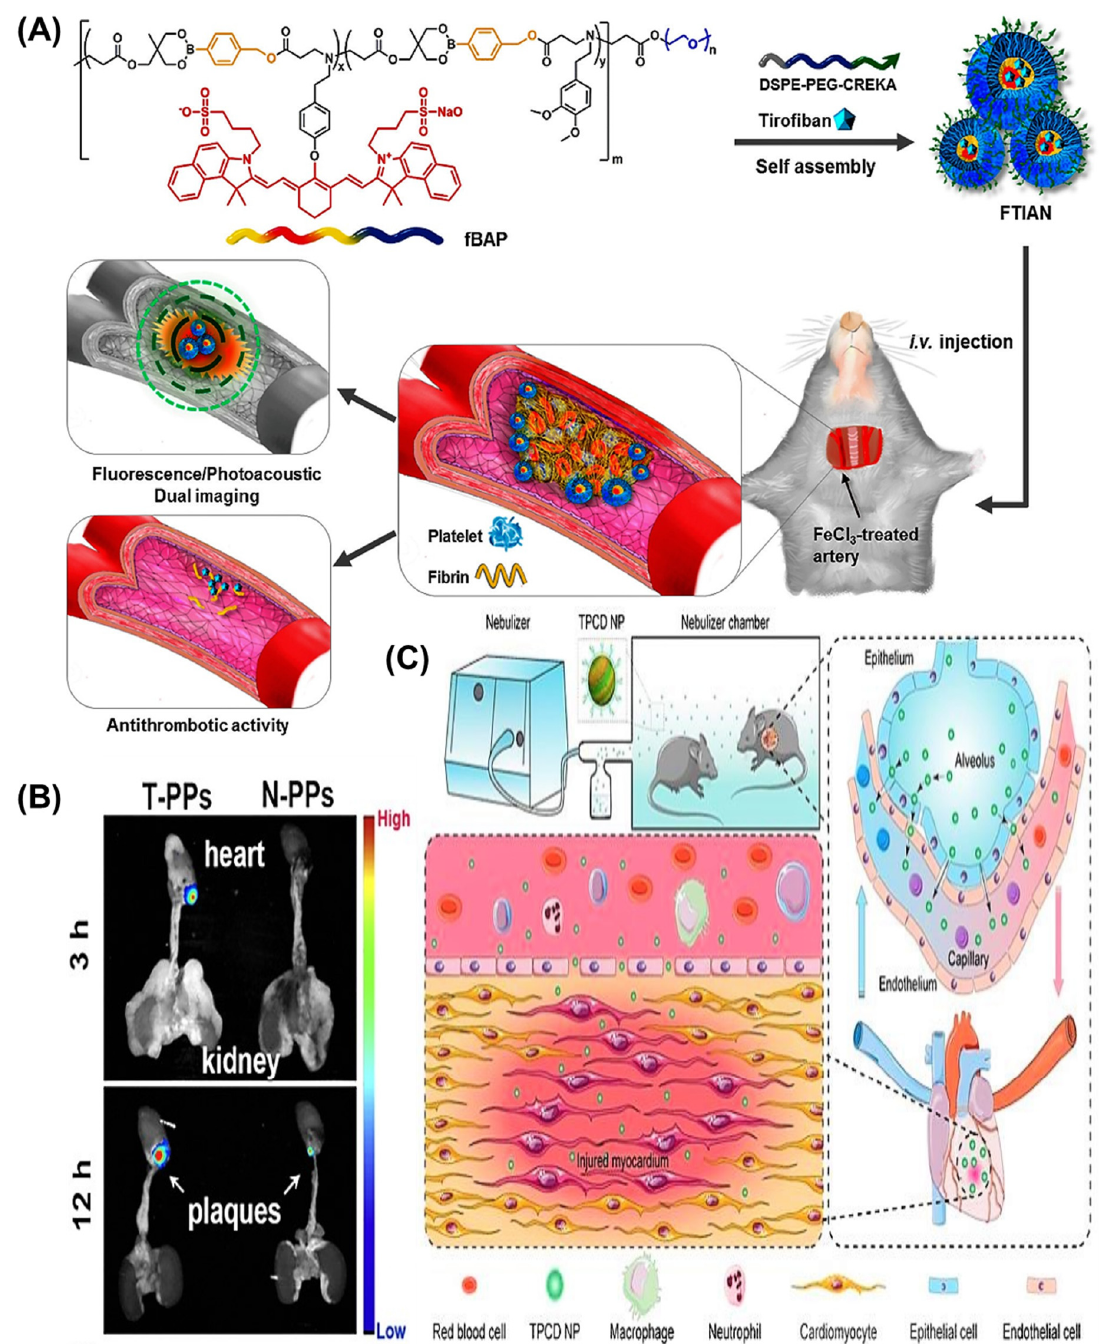
Figure 2. Theranostic nanomedicine for diagnosis and therapy of cardiovascular and related diseases. ( A ) A schematic representation of FTIAN as a fibrin targeted and H 2 O 2 responsive nanoparticles as theranostic for thrombosed vessel. Reproduced with permission from ref [54], scheme 1 (ACS ® 2017). ( B ) Ex vivo fluorescence imaging of the aortas at different time points after mice received tail vein injections of AF750-SCR loaded nanomedicines. Reproduced with permission from ref [91] Figure 6. (ACS ® , 2019). ( C ) Schematic illustration of in vivo targeting of the injured myocardium via inhalation of TPCD NPs. Reproduce with the permission from ref [48], Figure 1. (Ivyspring ® 2021). fBAP: Fluorescent dye-conjugated boronate antioxidant polymer; FTIAN: Fibrin targeted imaging and antithrombotic nanomedicine; CREKA: Pentapeptide Cys-Arg-Glu-Lys-Ala; FeCl 3 : Ferric chloride; DSPE: 1,2-distearoyl-sn-glycero-3-phosphoethanolamine; PEG: Poly ethylene glycol; NPPs: Non targeted polyplexes; TPPs: Targeted polyplexes; TPCD: A ROS scavenging material.